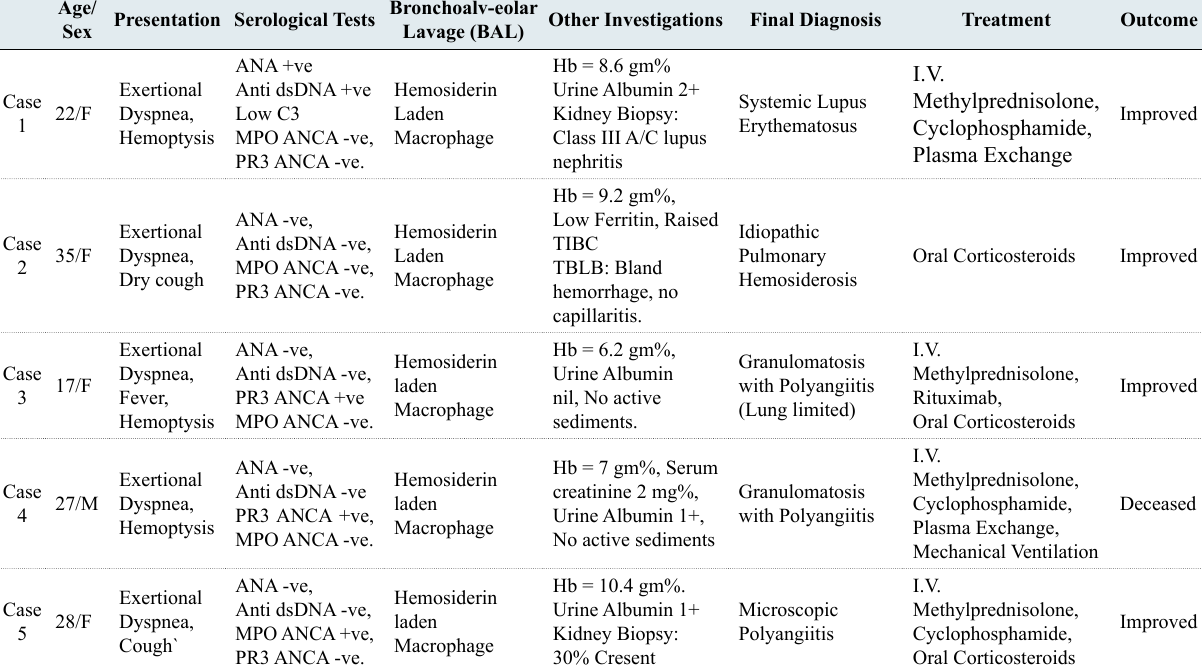
culture, fungal culture, AFB stain and Xpert MTB Rif assay BAL fluid. Transbronchial Lung Biopsy (TBLB) was done if Table 1: Clinical, laboratory results, treatment, and outcomes in patients with Diffuse Alveolar Hemorrhage Age/ Bronchoalv-eolar Presentation Serological Tests Other Sex Lavage (BAL)